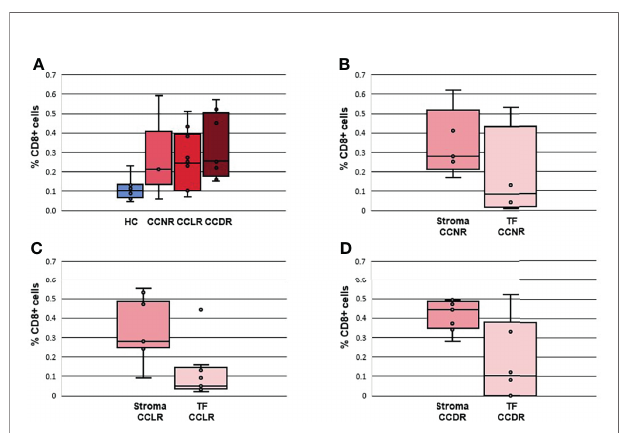
FIGURE 6 | Density ofCD8+ cellsincervical cancer tissues and healthy controls. The percentage of CD8+ cells iscalculated according to surface CD8+ cells/surface ofall cells *100. (A) Density CD8+ cells in allgroups. (B) Density CD8+ cells in CCNR comparing stromal tissue and tumor fi elds. (C) Density CD8+ cells in CCLR comparing stromal tissue and tumor fi elds. (D) DensityCD8+ cellsin CCDR comparing stromal tissue and tumor fi elds. TF, Tumor fi elds; HC, Healthy controls; CCLR, Cervical cancer localrecurrence; CCDR, Cervical cancer distant recurrence; CCNR, Cervical cancer no